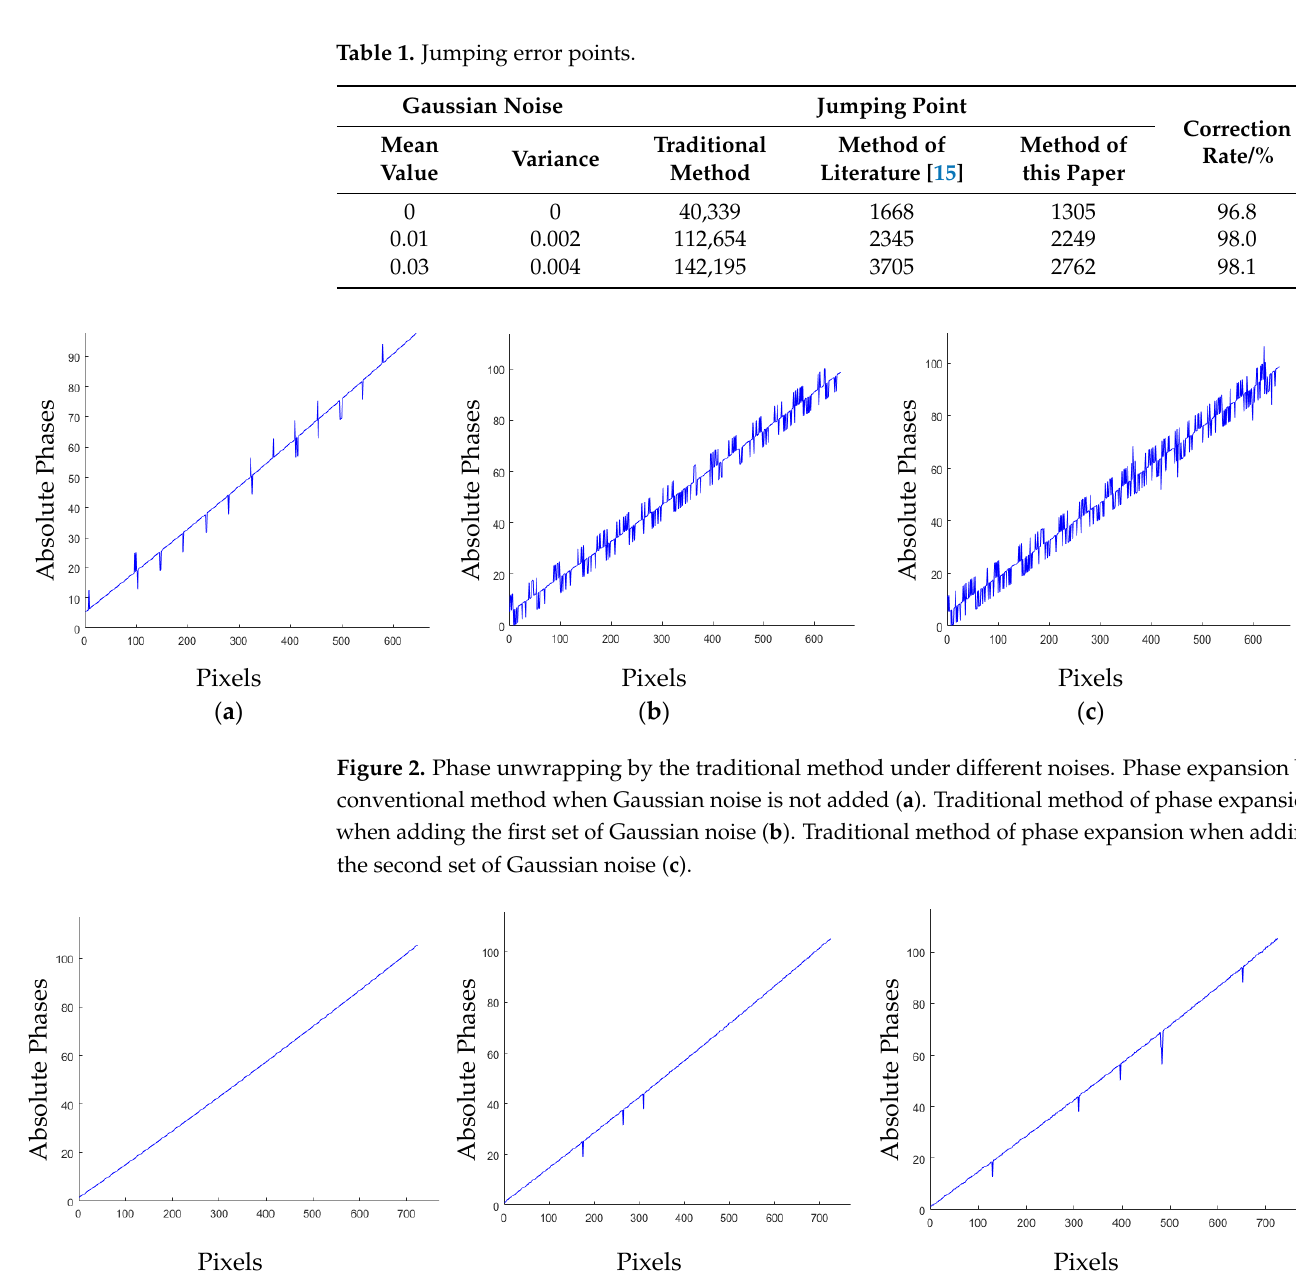
Figure 4. Phase unwrapping by the method of this paper under di ff erent noises. Phase expansion by the method of this paper when no Gaussian noise is added ( a ). The phase expansion is per- formed by the method of the this paper when adding the fi rst set of Gaussian noise ( b ). The phase expansion is performed by the method of the this paper when adding the second set of Gaussian noise ( c ). It is evident in Figure 2 that the phase unwrapped by the traditional dual-frequency heterodyne method undergoes many jumps; especially after the addition of noise, the number of jumping points increases dramatically, which introduces a lot of errors and the obtained absolute phase is not accurate. Meanwhile, it will also cause a great impact on the 3D reconstruction. As can be observed from Figure 3, the method in [15] improves the threshold value se tt ing for the jumping errors in the unwrapping phase. Adding fringe images with less noise can basically remove the jumps completely, but when faced with an environment with more noise, there will still be more jumping points. As shown in Figure 4, the jumps can be basically removed when the wrapping phase is unwrapped by the method in this paper, and the absolute phase rarely jumps, even in the face of varying noises, providing high noise immunity.